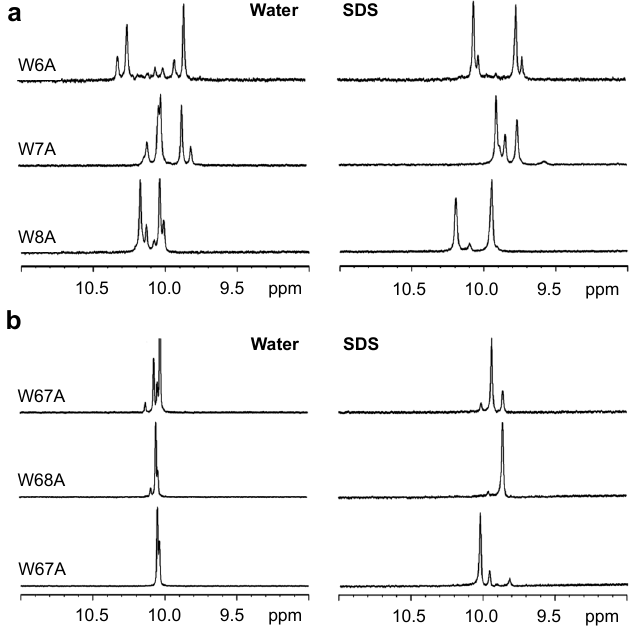
Figure 2. One-dimensional proton NMR spectra recorded for the H ε 1-tryptophan region of single- ( a ) and double- ( b ) Trp-substituted Tritrp1 peptides with Ala in aqueous solution ( left ) and in the presence of d 25 -SDS micelles ( right ) at 37